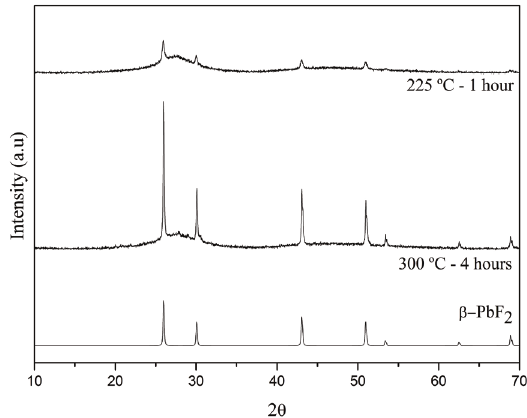
Figure 5. X-ray diffraction patterns of sample 60Pb heat-treated at 225 °C for 1 hour, 300 °C for 4 hours and crystalline β-PbF 2